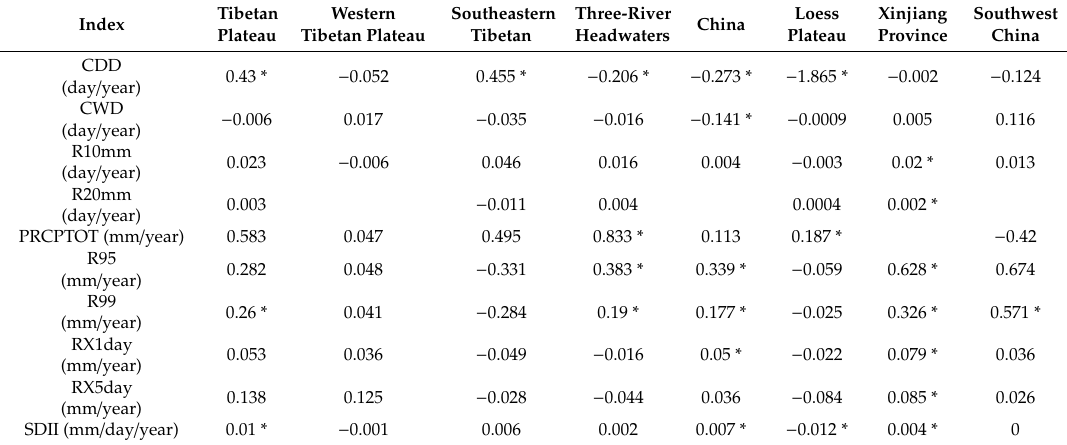
Table 7. Temporal variations in the extreme precipitation indices around the Tibetan Plateau from this study and other